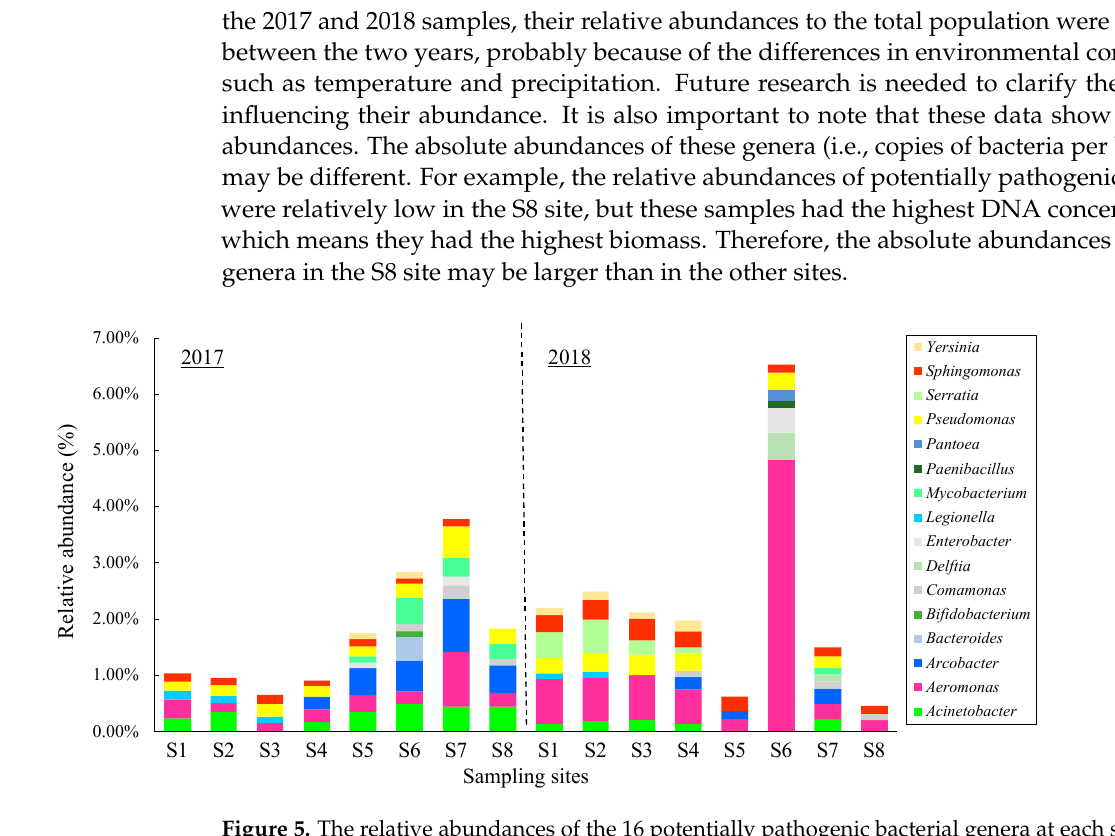
Figure 5. The relative abundances of the 16 potentially pathogenic bacterial genera at each site. Only major genera that were present at >0.1% of the population are shown.